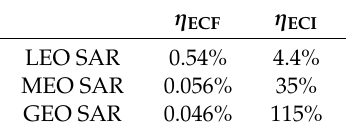
Figure 8. Baseline comparison of numerical optimization and proposed analytical expression for GEO InSAR. ( a ) Along-track baseline; ( b ) Perpendicular baseline.